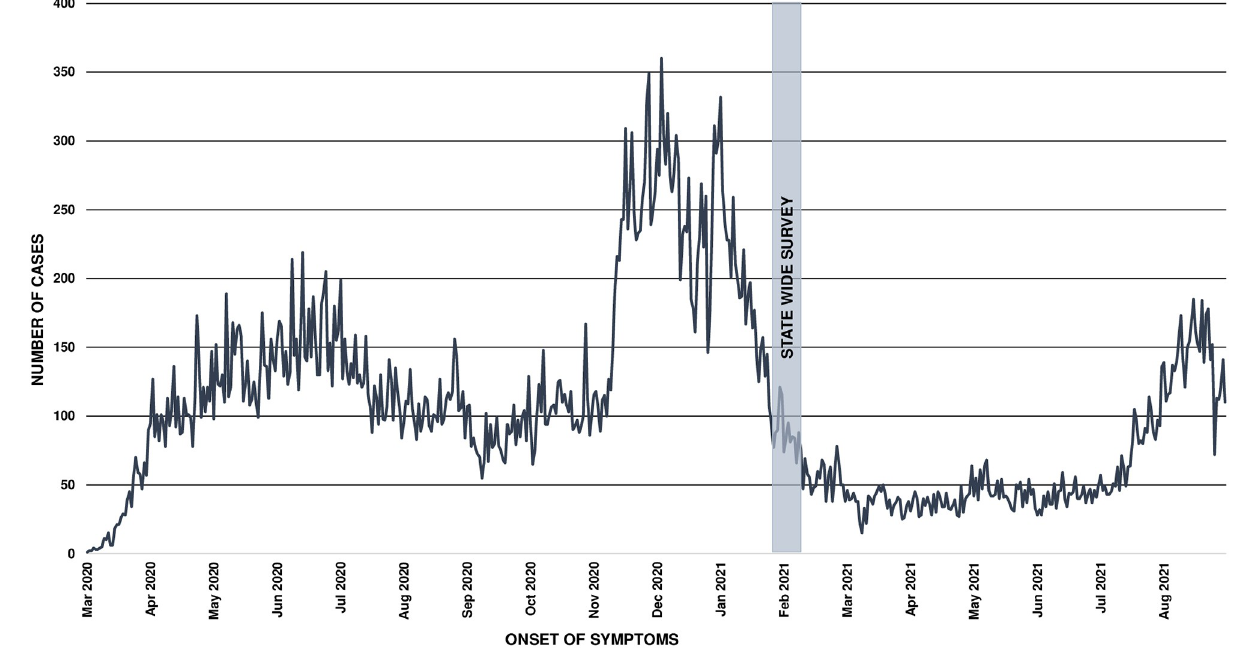
Fig 1. Epidemic curve in Baja California during the COVID-19 pandemic in 2020–2021.